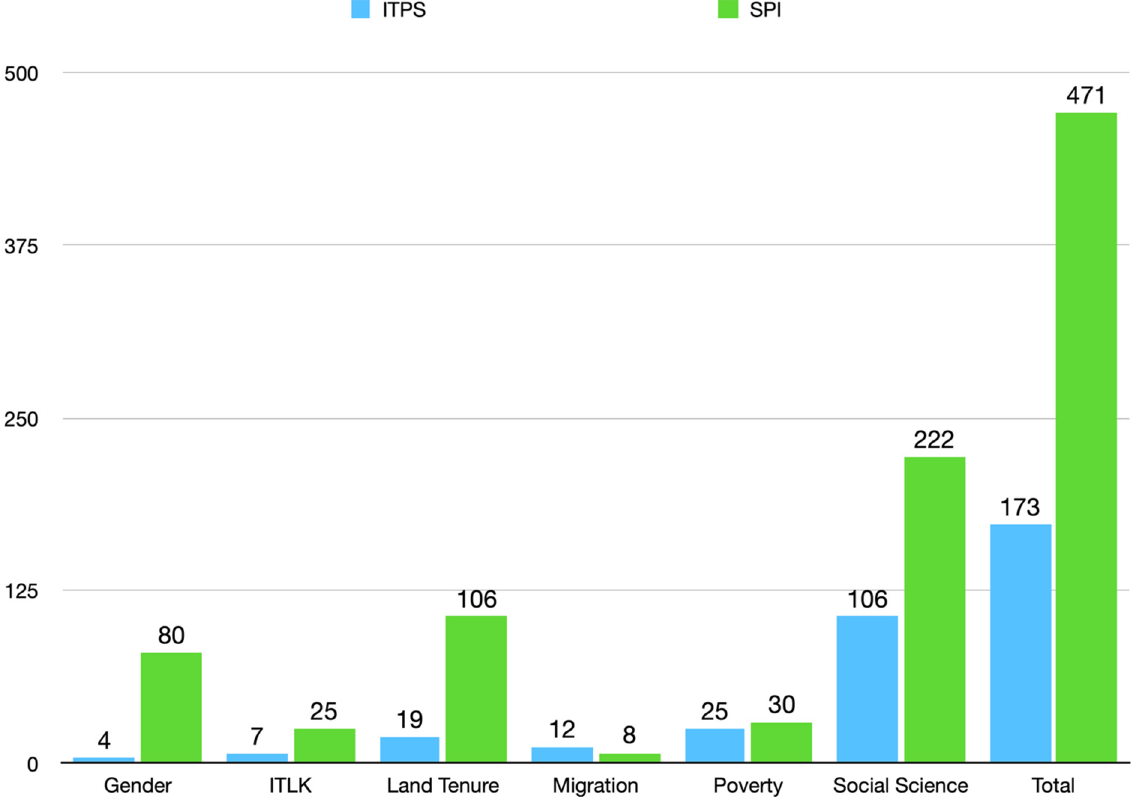
Figure 1. Occurrences of the subcategory ‘present’ for each